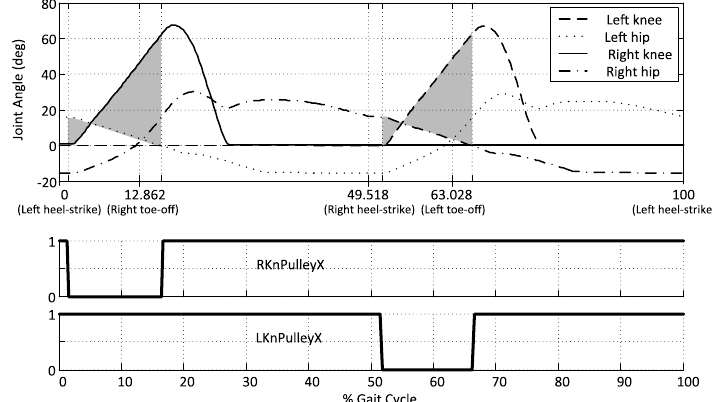
Fig. 9. Joint kinematics highlighting (shaded area) the coupling of the knee joint with the contralateral hip joint (above) and associated signals from the event detector.